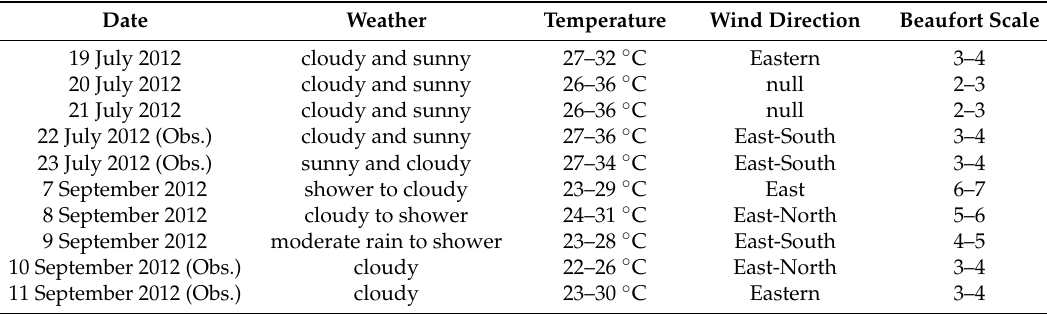
Table 4. Weather condition before and during the field